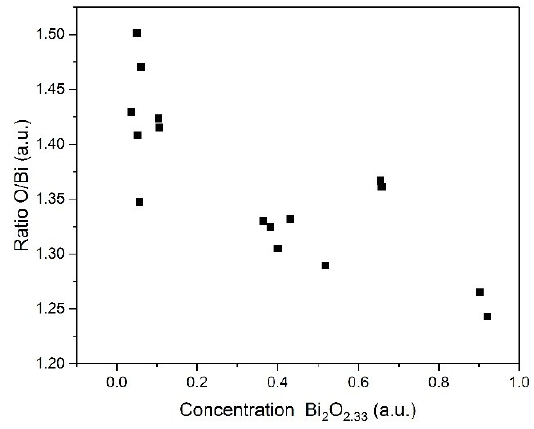
Figure 5. O / Bi ratio of XPS measurements vs. phase Figure 5. O/Bi ratio of XPS measurements vs. phase fraction.